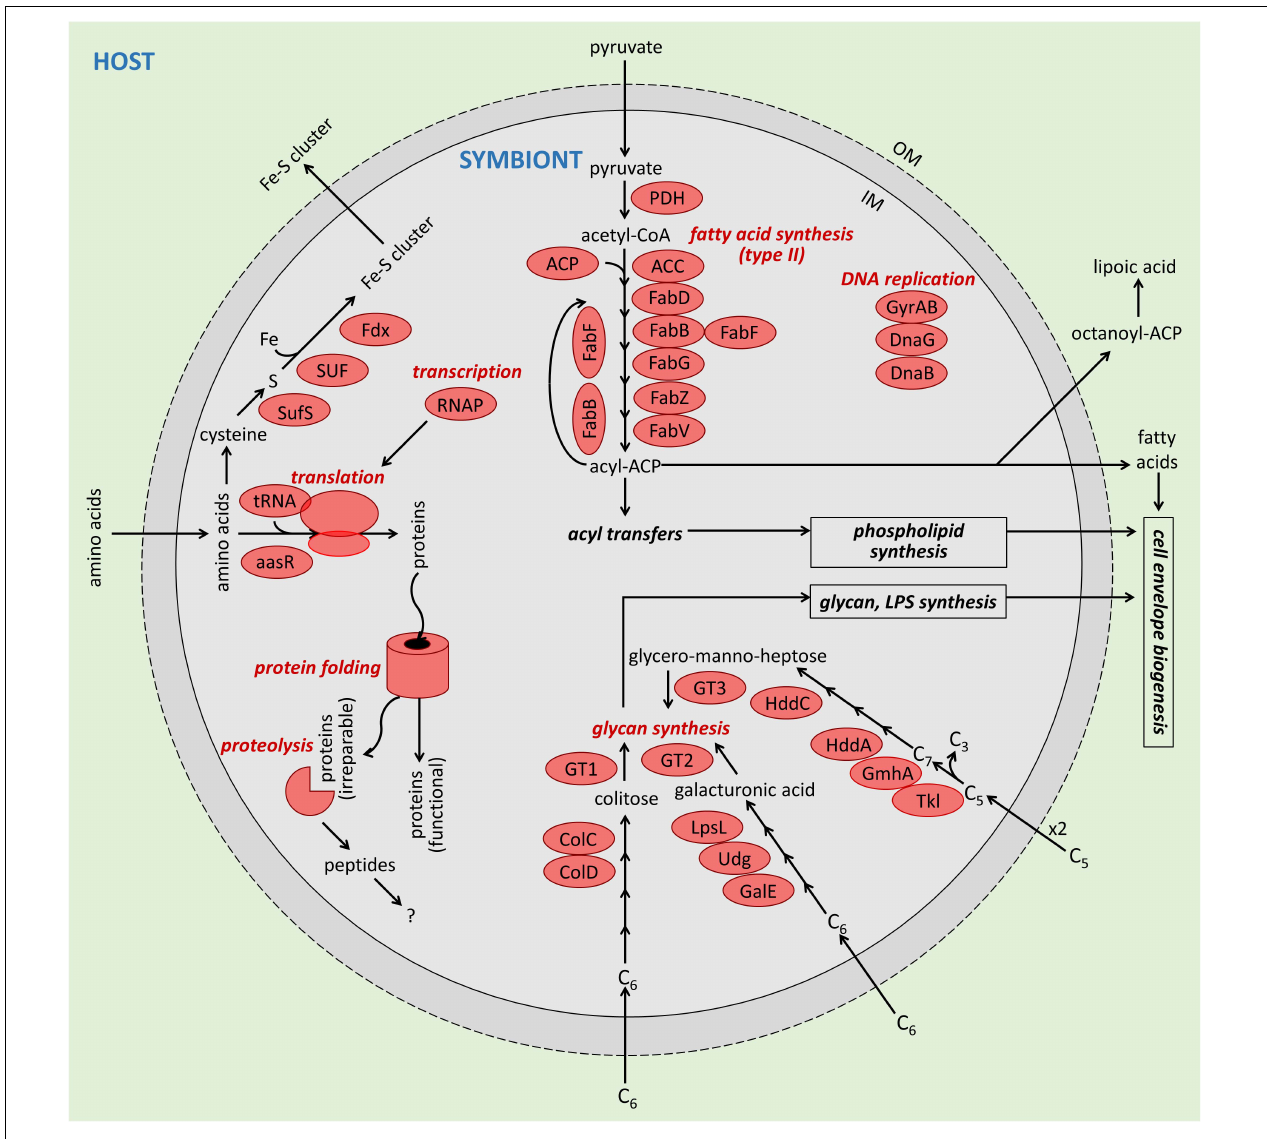
FIGURE 4 | Depiction of function of Candidatus Organicella extenuata within Euplotes sp. AntOrgLke. The potential metabolic capacities of Ca. Organicella extenuata are limited to pyruvate oxidation; type II fatty acid biosynthesis; iron-sulfur (Fe-S) cluster assembly; and conversion, activation, and transfer of hexose and heptose sugars. The Ca. Organicella extenuata MAG lacks any identifiable genes for glycolysis, tricarboxylic acid cycle (aside from pyruvate oxidation), pentose phosphate pathway, respiration, fermentation, ATP generation (either by oxidative phosphorylation and ATP synthase, or substrate-level phosphorylation), or synthesis of phospholipids (aside from fatty acids), amino acids, nucleic acids, or vitamins. There were no identifiable transporter genes. Processes, pathways, and enzymes that were inferred to be functional in Ca. Organicella extenuata are shaded in red. OM, outer membrane; IM, inner membrane; LPS, lipopolysaccharide. Fatty acid synthesis (type II): PDH, pyruvate dehydrogenase; CoA, coenzyme A; ACP, acyl carrier protein; ACC, acetyl-CoA carboxylase complex; FabD, malonyl-CoA-ACP-transacylase; FabB and FabF, 3-oxoacyl-ACP synthase; FabG, 3-oxoacyl-ACP reductase; FabZ, 3-hydroxyacyl-ACP dehydratase; FabV, enoyl-ACP reductase. Glycan synthesis: GT, glycosyltransferase (three different GT); ColD, GDP-4-keto-6-deoxy- D -mannose 3-dehydratase; ColC, GDP- L -colitose synthase; Udg, UDP-glucose 6-dehydrogenase; LpsL, UDP-glucuronate epimerase; Tkl, transketolase; GmhA, phosphoheptose isomerase; HddA, D -glycero- α - D -manno-heptose 7-phosphate kinase; HddC, D -glycero- α - D -manno-heptose 1-phosphate guanylyltransferase. DNA replication: GyrAB, DNA gyrase; DnaG, DNA primase; DnaB, replicative DNA helicase. Transcription: RNAP, RNA polymerase. Translation: tRNA, transfer RNA; aaRS, aminoacyl tRNA synthetases. Fe-S cluster assembly: Fdx, ferredoxin; SufS, cysteine desulfurase; SUF, Fe-S cluster assembly complex (SufCBD, SufU, SufT). In this reconstruction, pyruvate is supplied by the host and the sole purpose of PDH is to provide the acetyl-CoA precursor for fatty acid synthesis. The fatty acid synthesis pathway is functionally complete in Ca. Organicella extenuata, with FabF or FabB substituting for missing FabH. There are three pathways involved in synthesis of heptose (glycero-manno-heptose) or hexose (galacturonic acid; colitose) subunits of lipopolysaccharide glycans in Ca. Organicella extenuata, but none of these pathways are complete, and all depend on exogenous